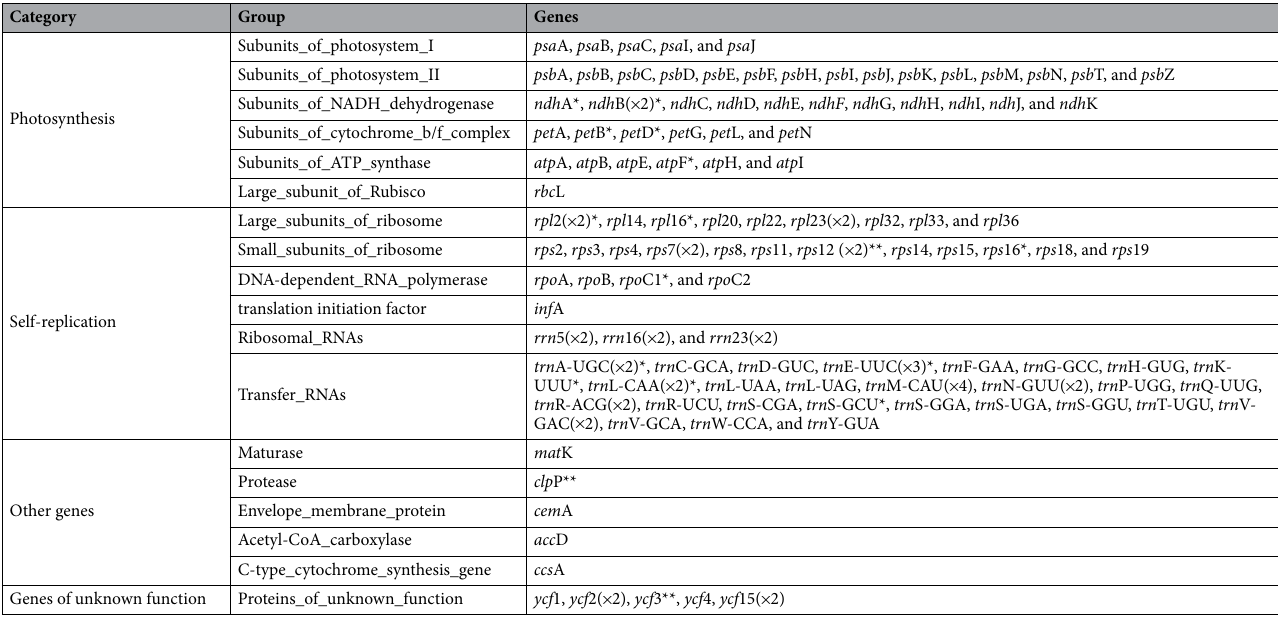
Table 2. Genes encoded by two Launaea and eight Reichardia chloroplast genomes. (×N) indicates the genes that have N copies. * and ** indicate genes containing one and two introns,